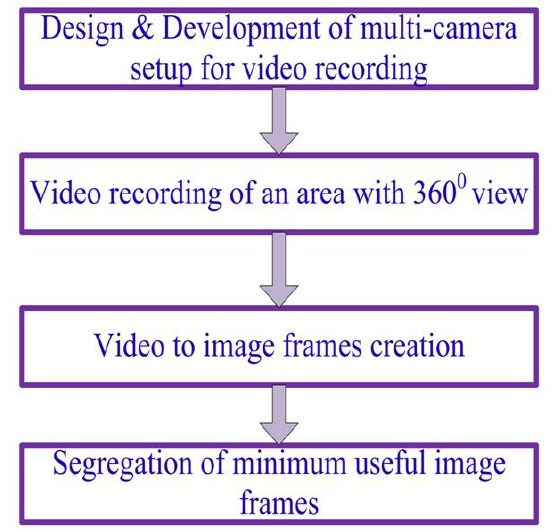
Figure 3, is showing some video image frames created by this software.